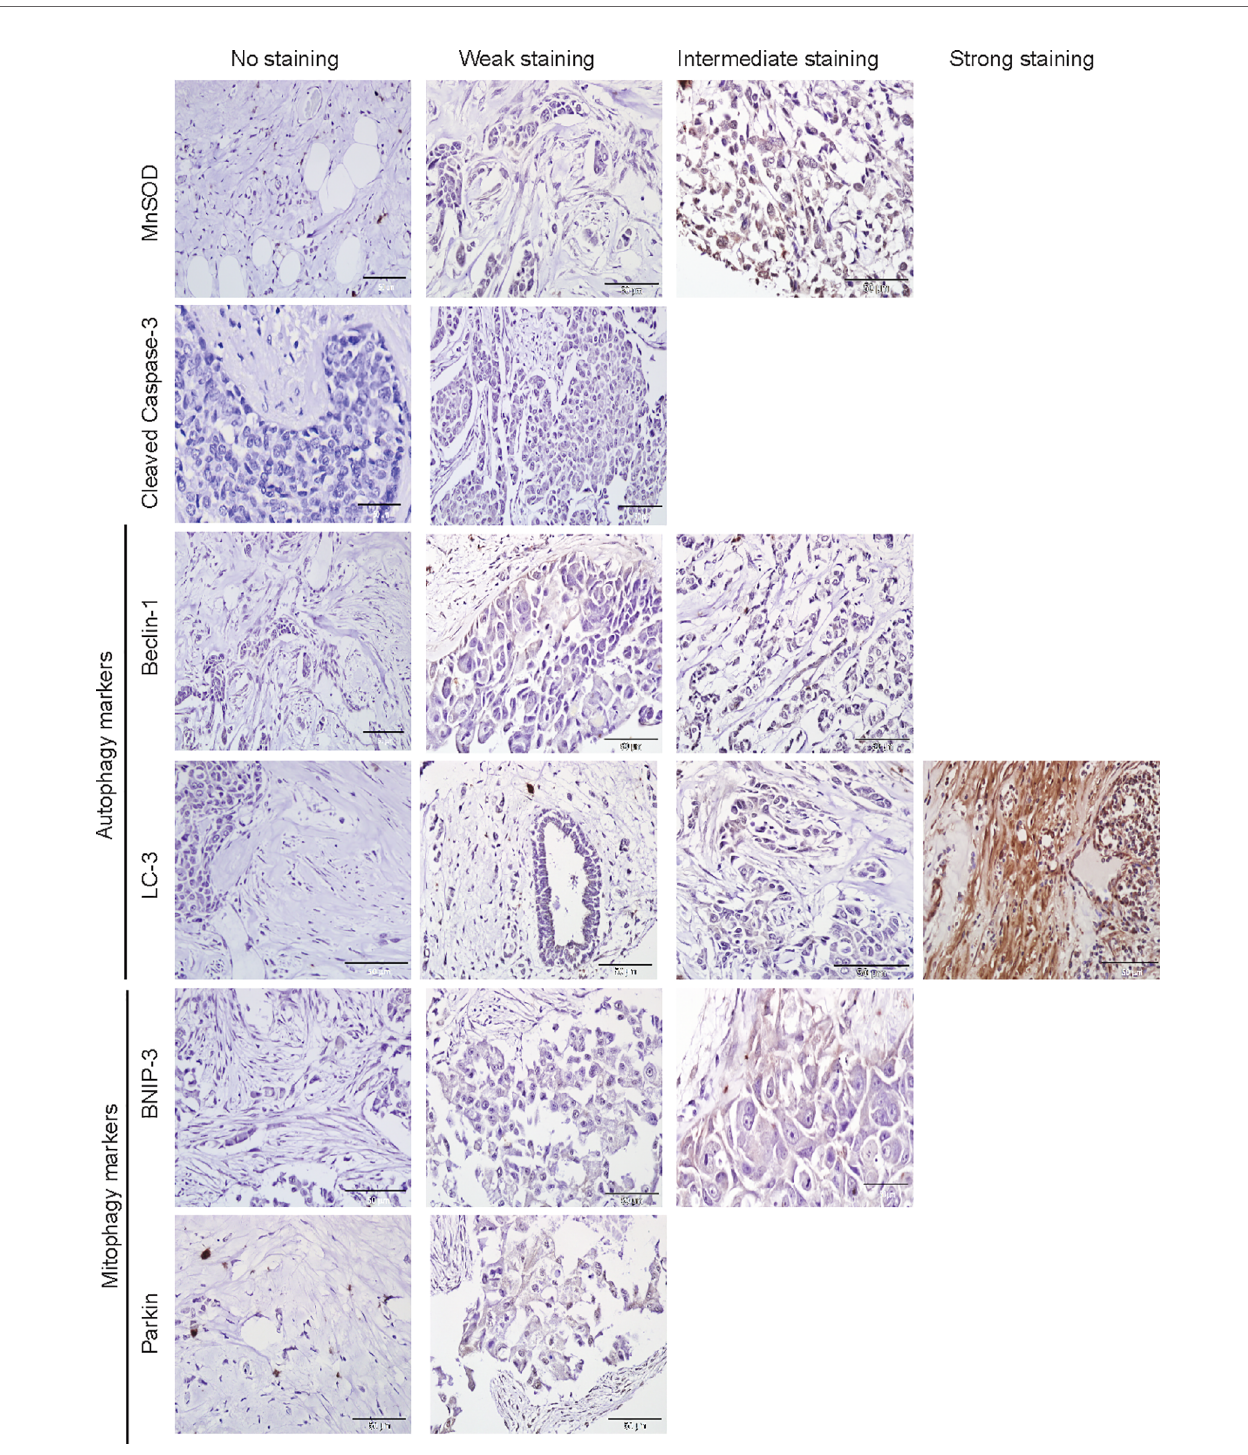
FIGURE 2 | Immunohistochemical staining of MnSOD, cleaved caspase-3, Beclin-1, LC-3, BNIP-3, and Parkin in adjacent normal tissues. Representative images of MnSOD, cleaved caspase-3, Beclin-1, LC-3, BNIP-3, and Parkin staining (scored no, weak, intermediate, and strong staining) of adjacent matched control tissues obtained from breast cancer patient samples ( n =